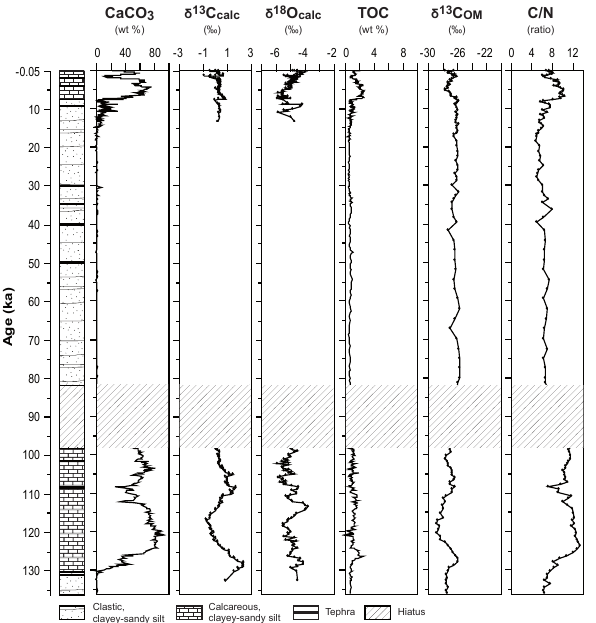
Fig. 4. Calcite and organic matter concentration and isotope data from Lake Ohrid core Co1202.